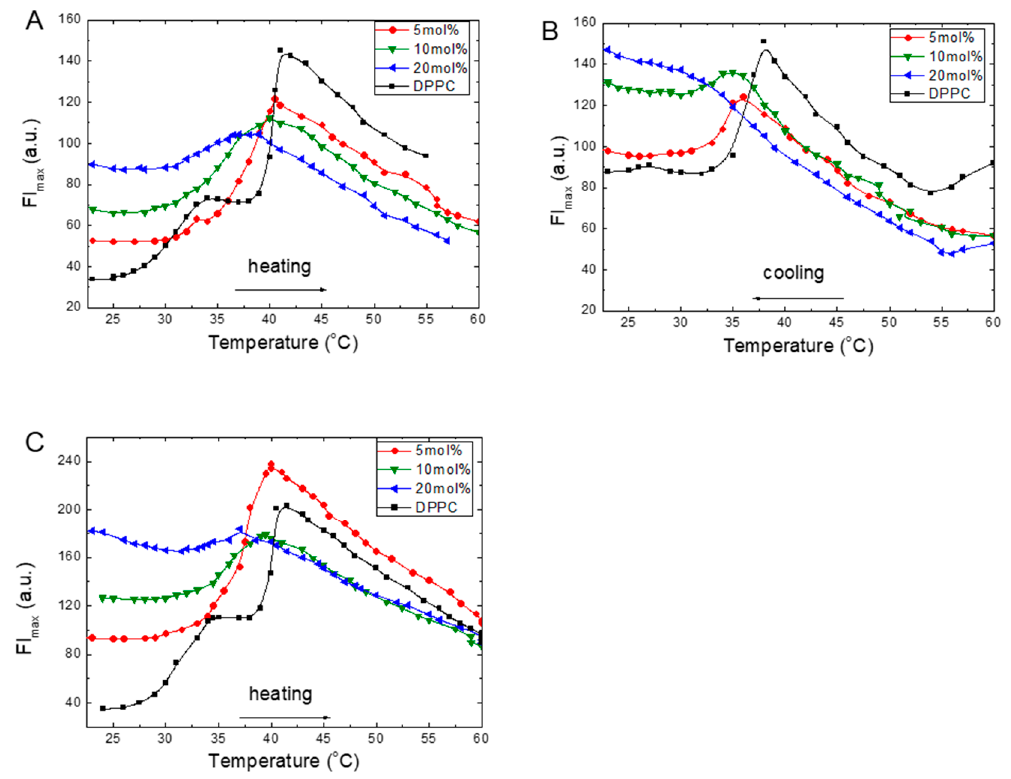
Figure 1. Fluorescence intensity in the maxima of emission (FI max ) changes of 1-anilino-8-naphtalene sulphonate (ANS) (16 µ M) added to the 1,2-Dipalmitoyl-sn-glycero-3-phosphocholine (DPPC) (0.08 mg / mL) with an increasing concentration of α -Tocopheryl succinate (TS) during heating ( A ), cooling ( B ) or α -Tocopherol (Toc) during heating ( C